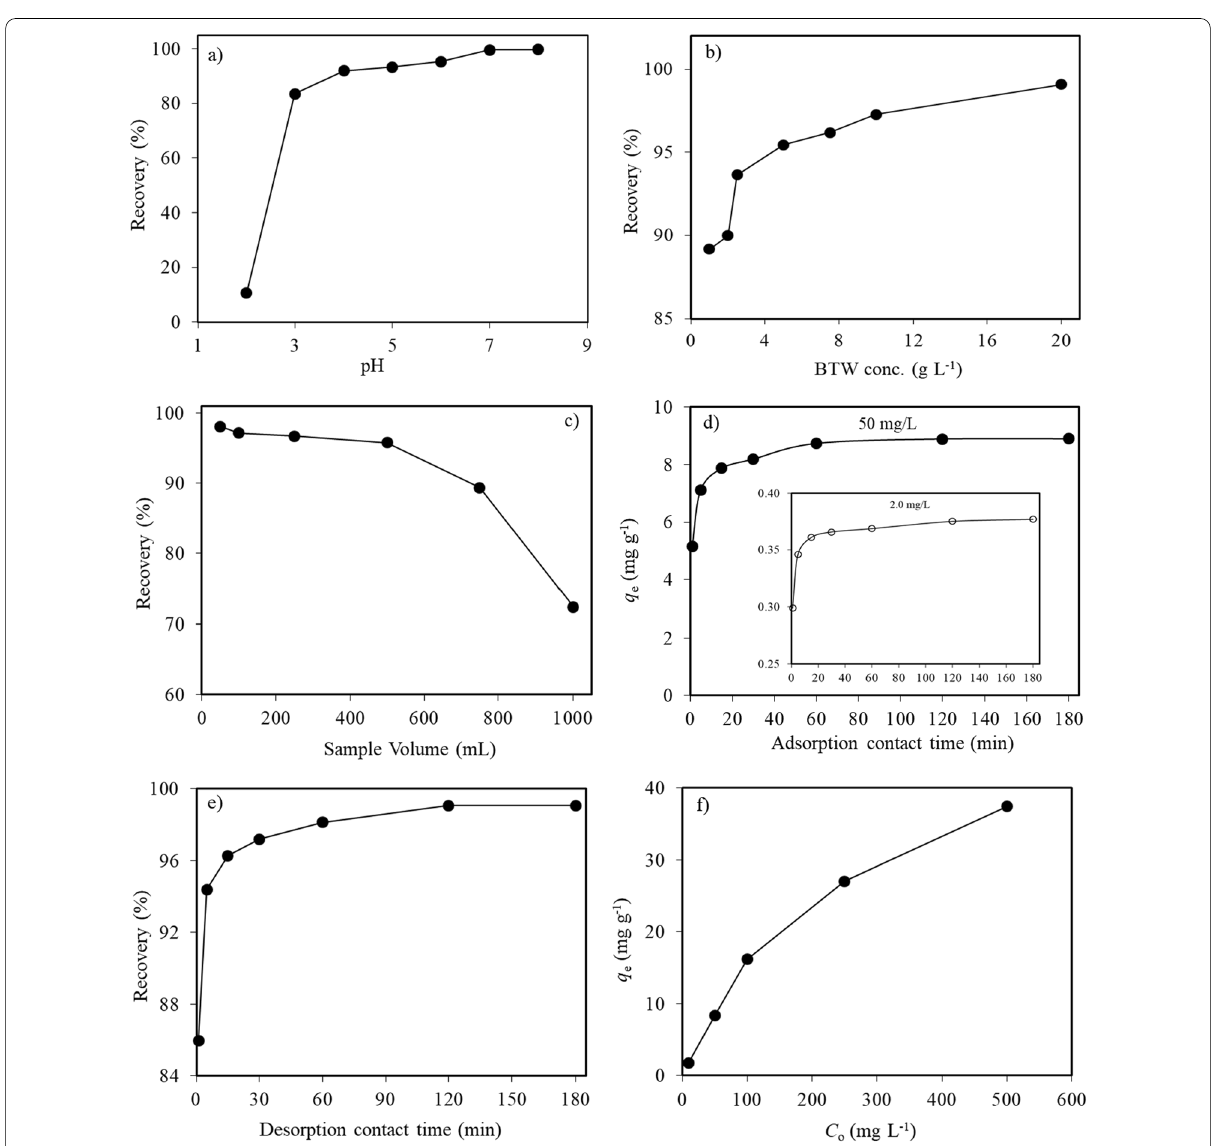
Fig. 4 Influences of a pH, b BTW amount, c sample volume, d adsorption equilibrium time, e desorption contact time, f initial Cd(II) concentration on the adsorption and recovery of Cd(II)